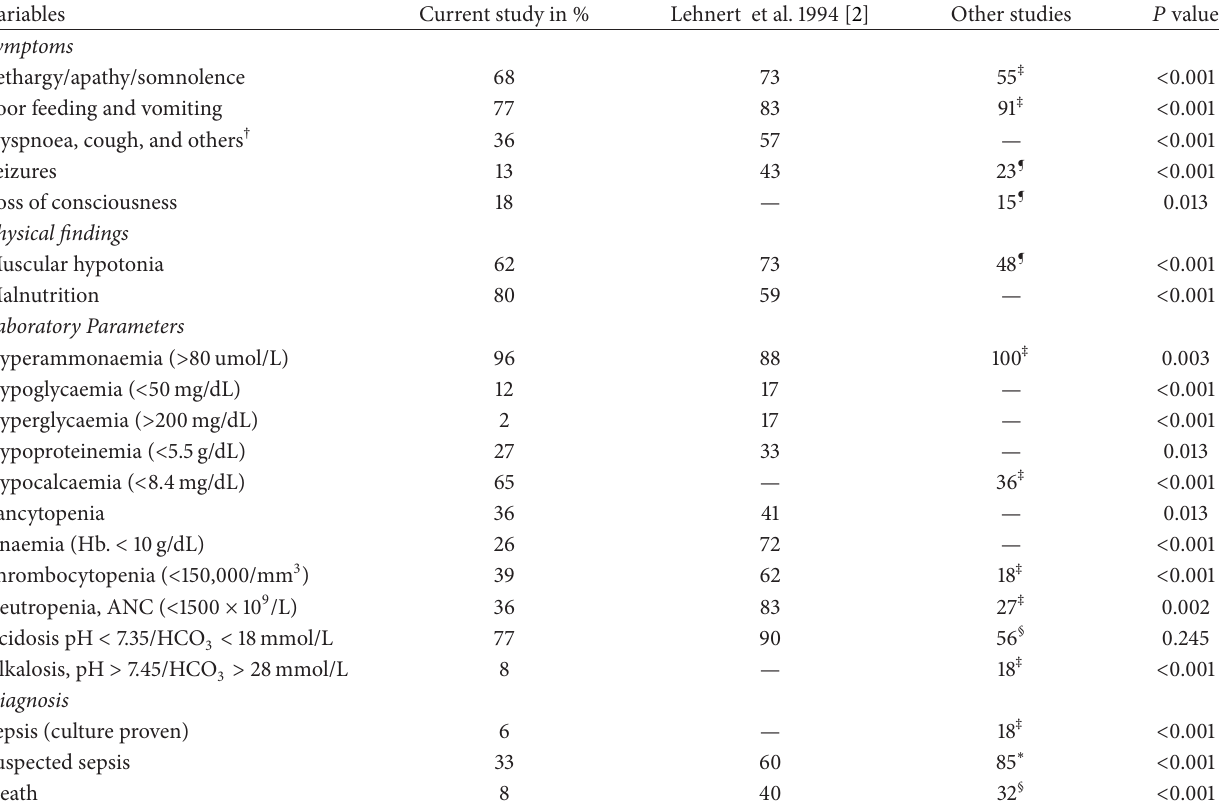
Table 2: Important clinical, physical, and laboratory findings and diagnoses of diseases on initial presentation in 133 admissions of 26 patients with PA and comparison of these findings with other